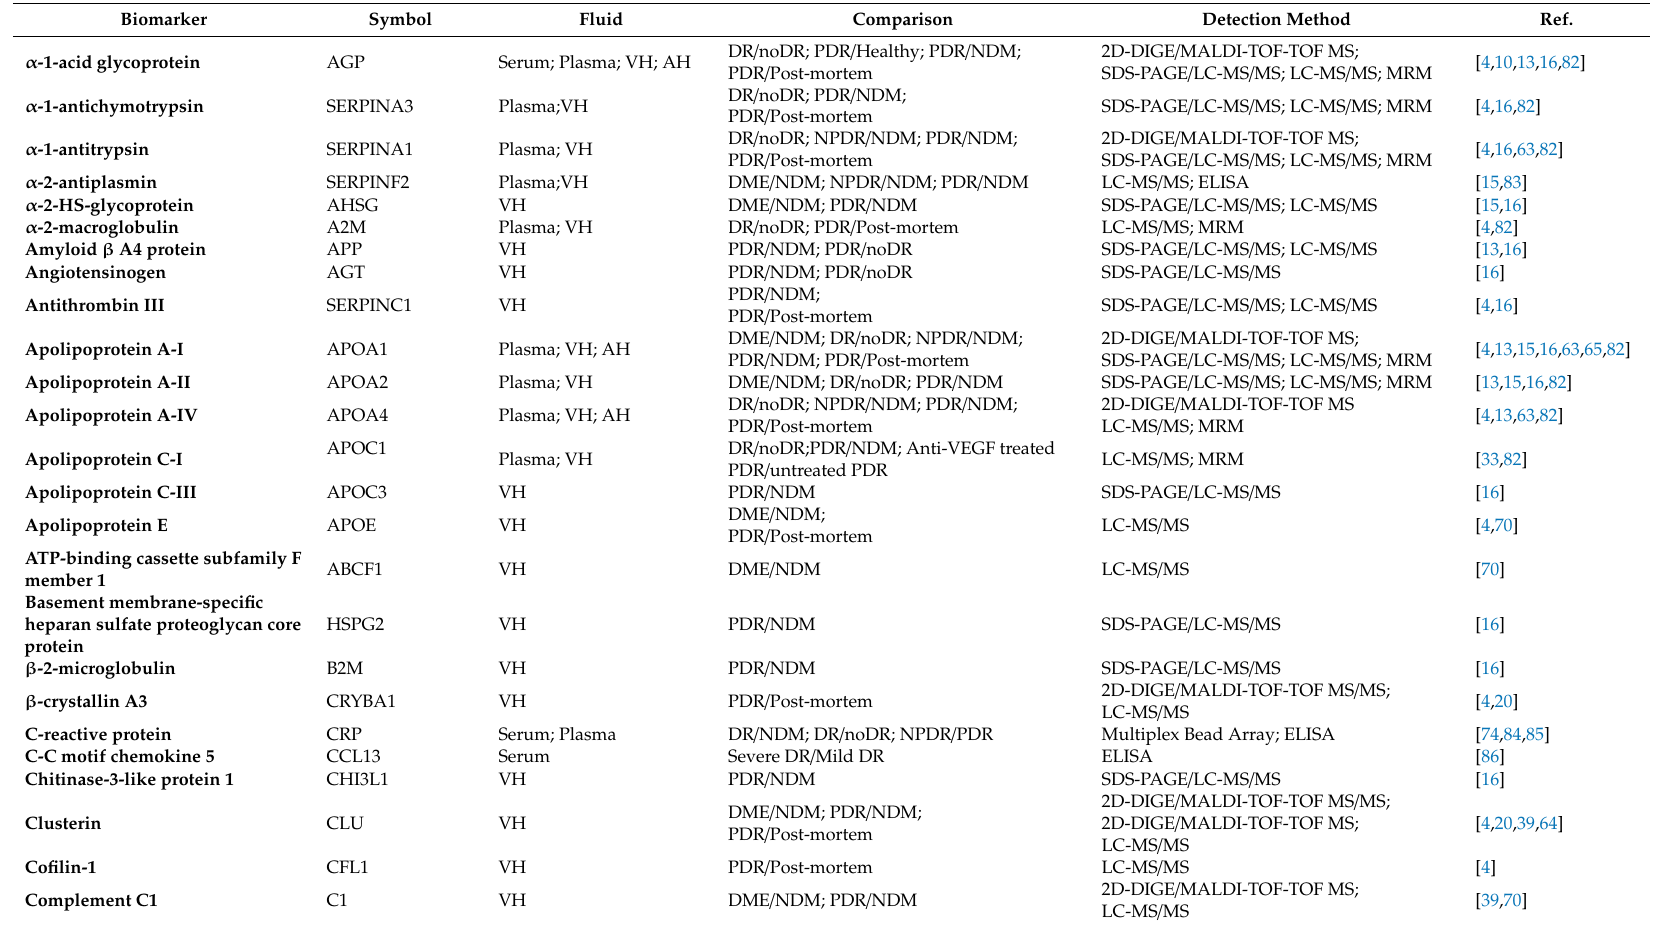
Table 1. Biomarkers of retinal inflammation in diabetic retinopathy (DR) patients detected using proteomic approaches. Biomarker Comparison Detection Method